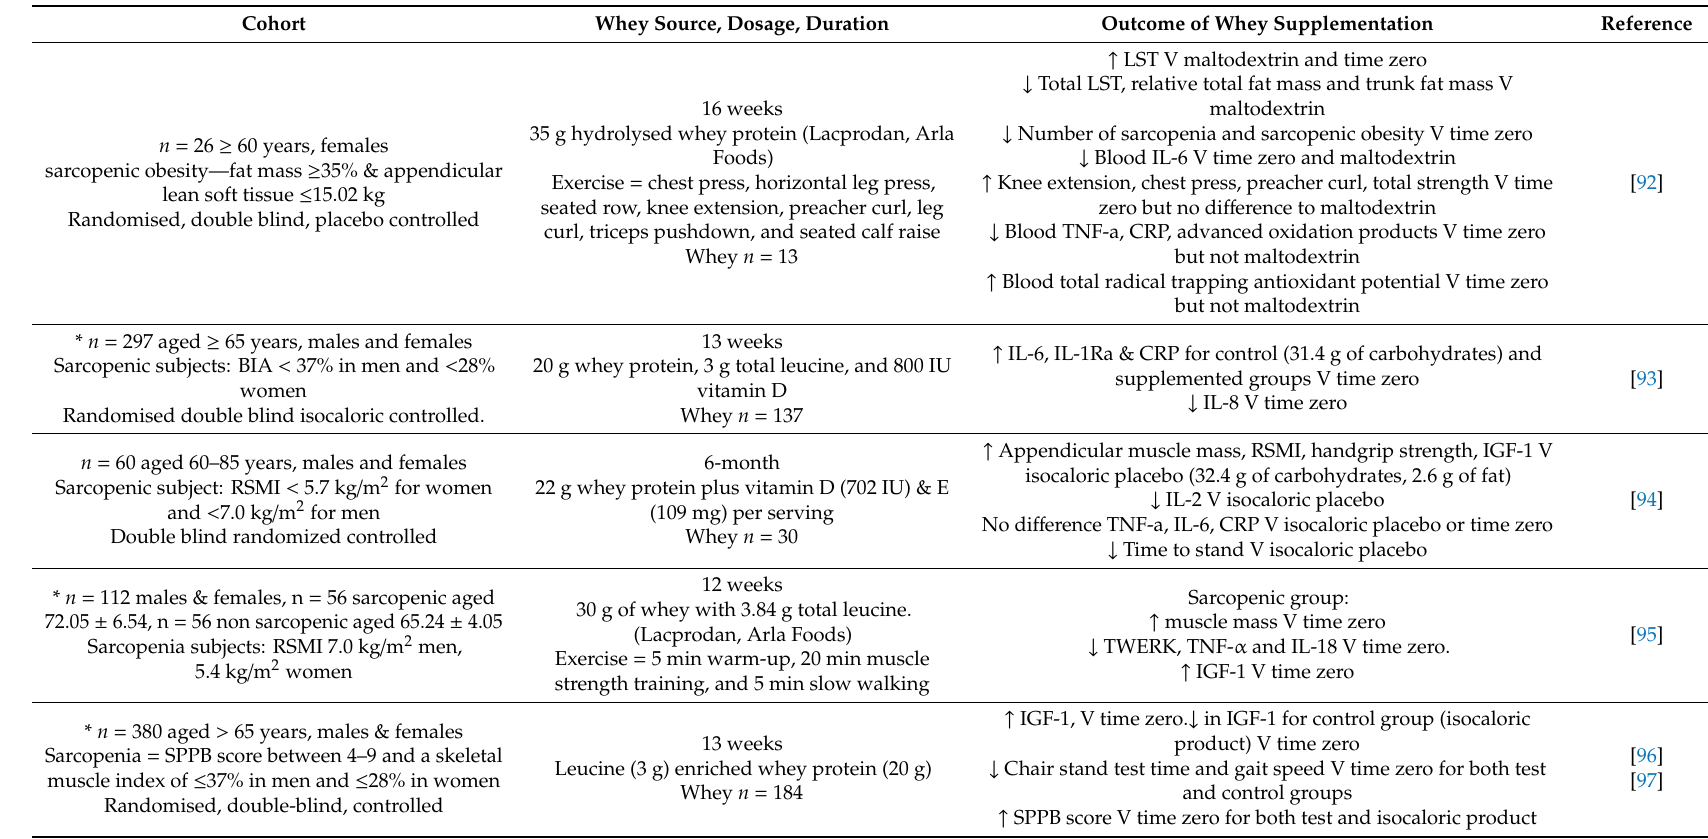
Table 6. Whey intervention trials involving older individuals with sarcopenia. LST: Lean soft tissue; IL-6: Interleukin 6; TNF- α : Tumor necrosis factor alpha; CRP: C reactive protein; BIA: Bio-Impedance Analysis; IL-1Ra: Interleukin 1 receptor antagonist; IL-8: Interleukin 8; RSMI: Relative muscle mass index; IGF-1: Insulin-like growth factor 1; IL-2: Interleukin 2; TWEAK—Tumor necrosis factor-like WEAK inducer of apoptosis; IL-18 Interleukin 18; SPPB: Short Physical Performance Battery. * power calculation to determine number of subjects was performed. Whey Source, Dosage, Duration Outcome of Whey Supplementation